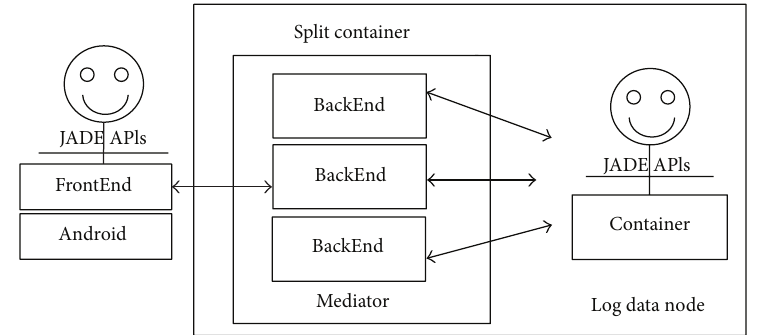
Figure 12: The JADE architecture of the X73 Sink node.